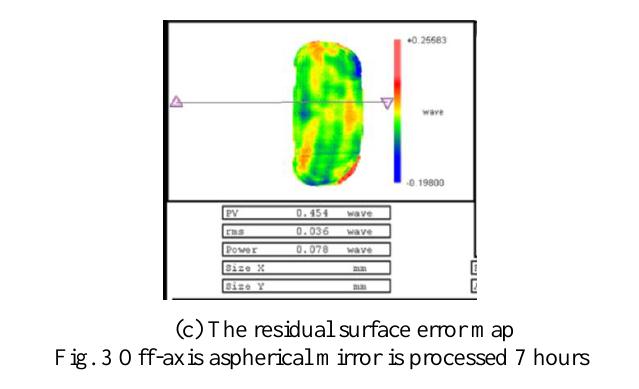
Fig. 2 ZYX Euler angle